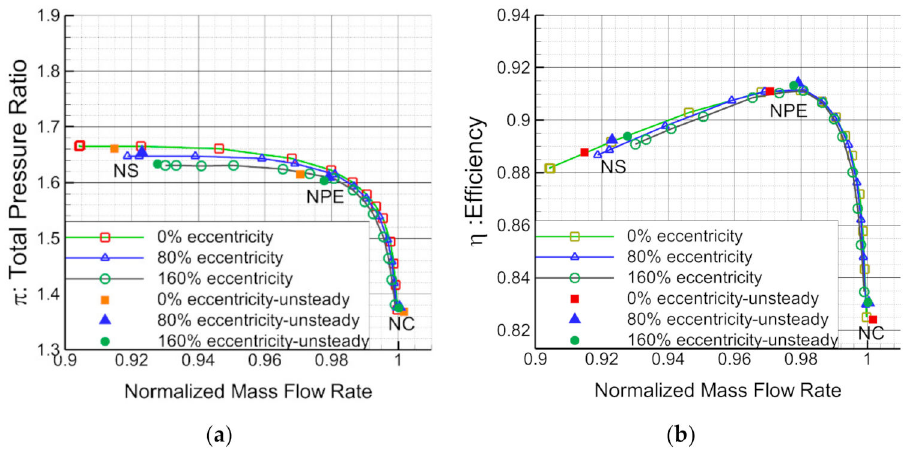
Figure 9. E ff ect of eccentricity on the performance curve. ( a ) E ff ect of eccentricity on the total pressure ratio; ( b ) e ff ect of eccentricity on the e ffi